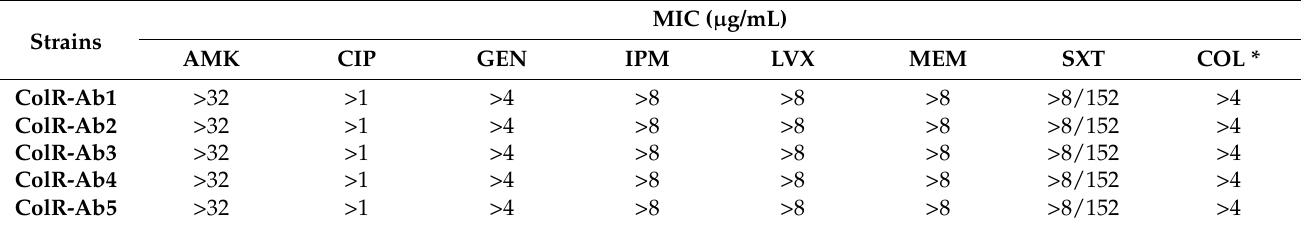
Table 2. The antimicrobial resistance profiles for ColR-Ab